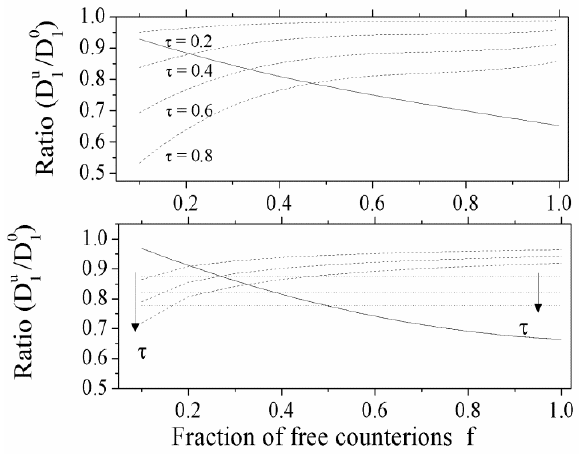
/ u D D on the polyelectrolyte 1 1